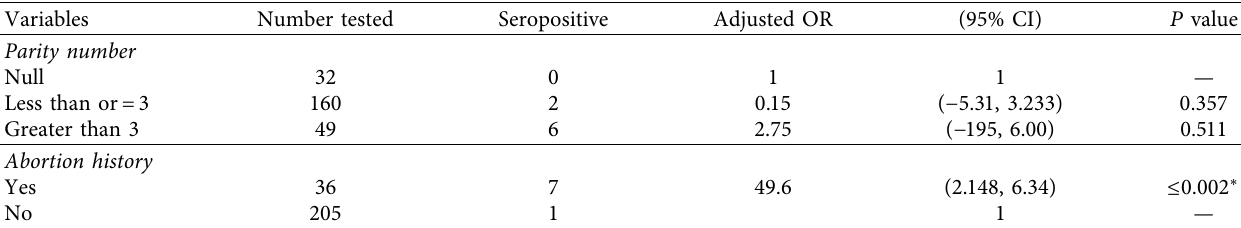
Table 3: Multivariable Firth’s bias-reduced logistic regression analysis of factors associated with brucellosis seropositivity in camel.